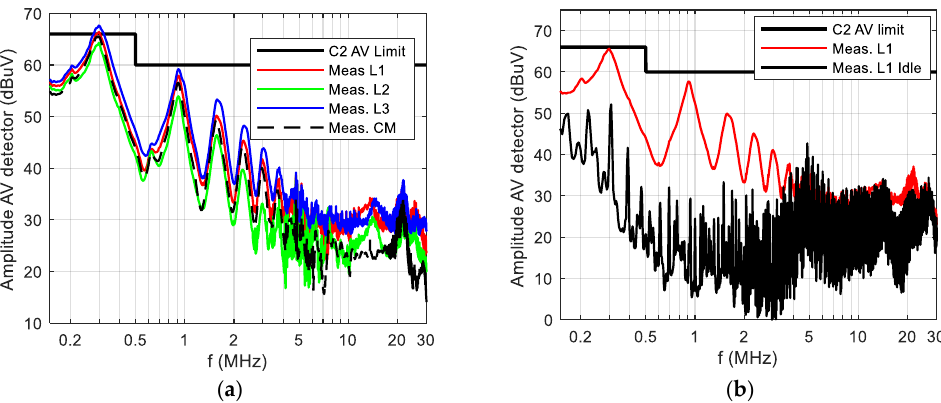
Figure 4. Measured average detected grid noise of all three phases L1, L2, and L3 with a 100 m motor cable (16 mm 2 ) during ( a ) normal operation with motor rotation ( b ) comparison between the noise of normal operation and the motor at standstill with no switching at inverter